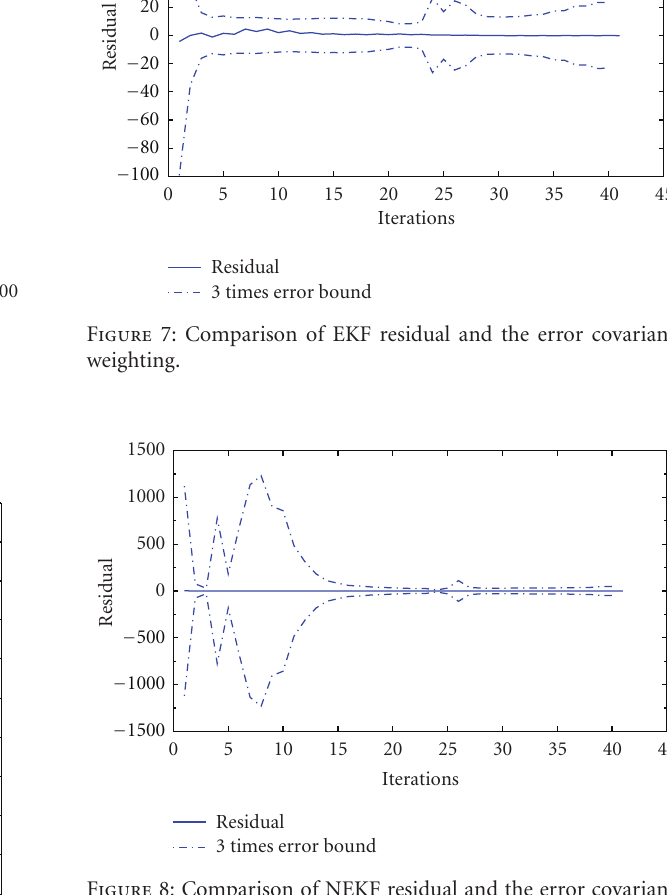
Figure 8: Comparison of NEKF residual and the error covariance